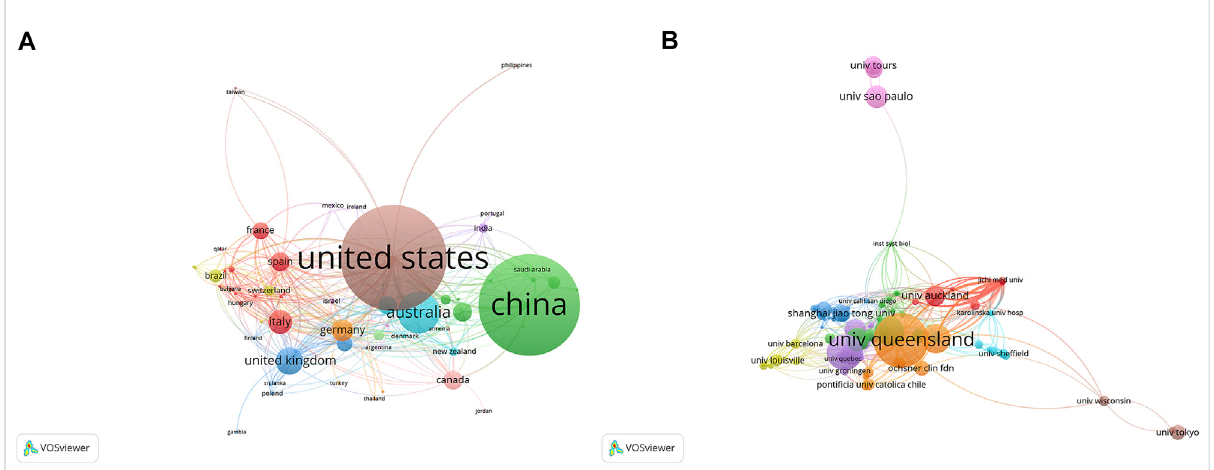
FIGURE 3 The distribution of countries and institutions publishing research on exosomes in reproduction. (A) The network map of countries/regions publishing research on exosomes in reproduction. (B) The network map of institutes involved in research on exosomes in reproduction.